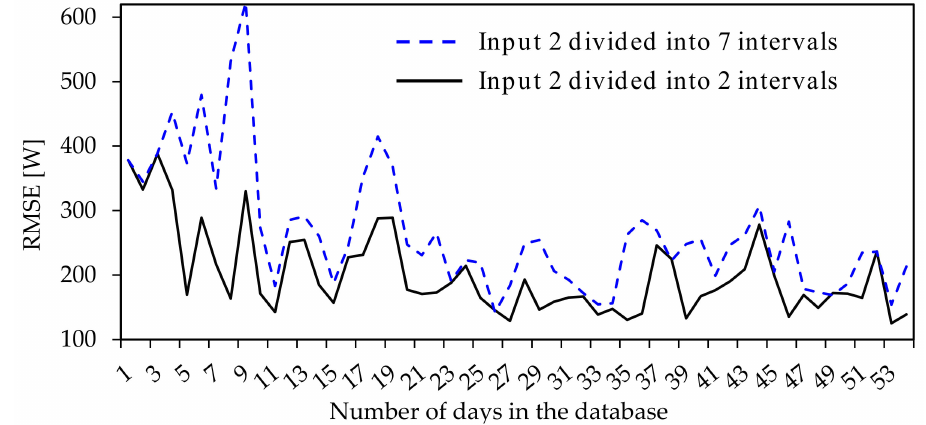
Figure 14. Root Mean Square Error comparison for input 2